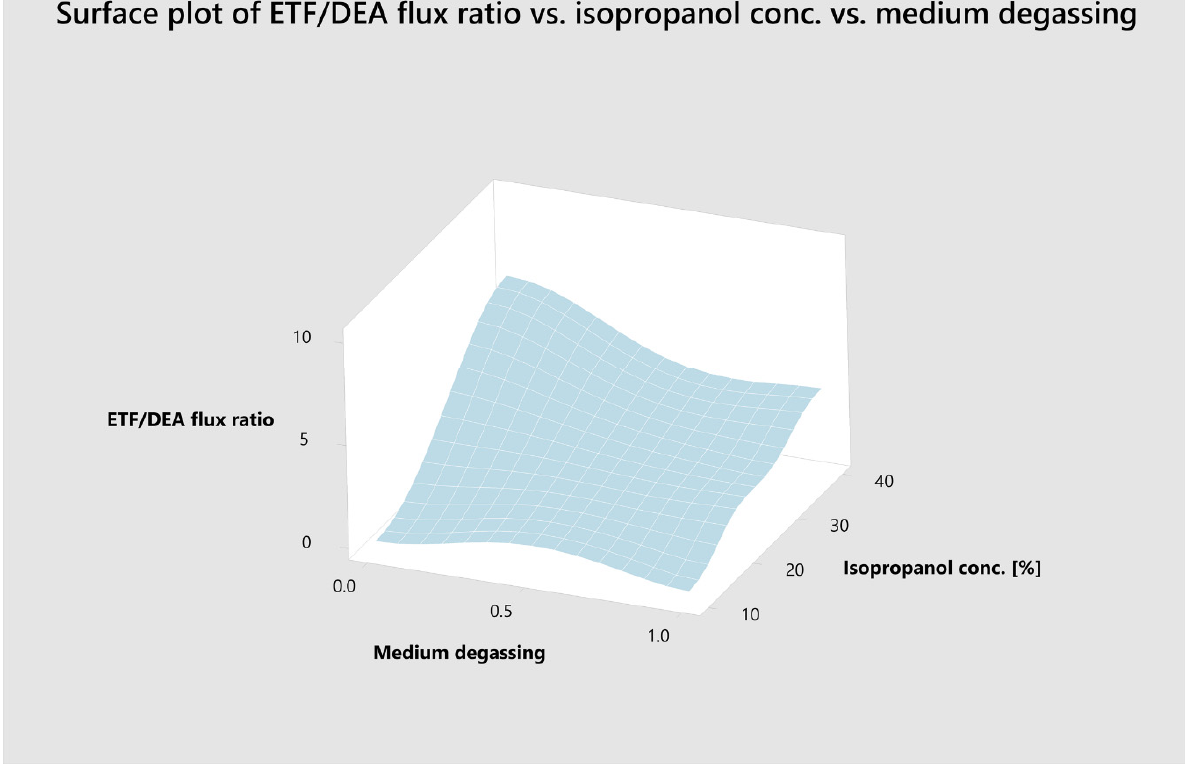
Figure 2. Response surface (3-D) plot illustrating the effect of isopropanol concentration and medium degassing on ETF/DEA flux ratio values.